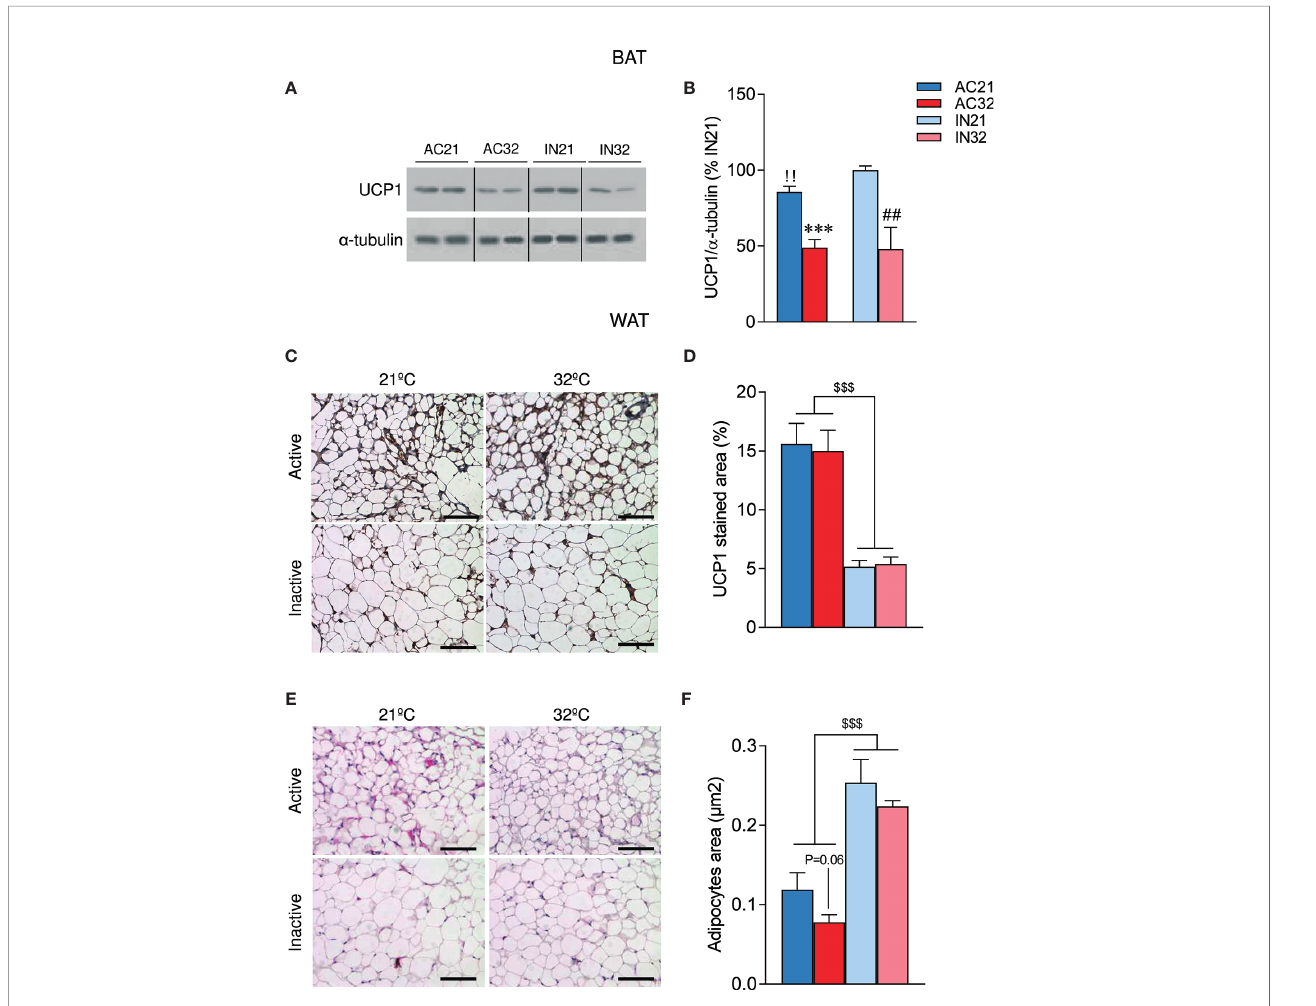
FIGURE 3 | Effect of ABA and temperature on BAT and WAT browning. (A, B) Protein levels of UCP1 in the BAT (n = 7 rats/group) (C, D) UCP1 staining in WAT (n = 8-12 rats/group) (E, F) Adipocyte are in WAT (n = 8-12 rats/group) of active rats at 21°C and 32°C (AC21 and AC32) and inactive rats at 21°C and 32°C (IN21 and IN32). ***P < 0.001 vs. AC21; ## P < 0.01 vs. IN21; !! P < 0.01 IN21 vs. AC21; $$$ P < 0.001 for simpli fi cation. Data expressed as mean ± SEM. The bands in gels from panel (A) have been spliced from the same original gels. Scale bar: 100